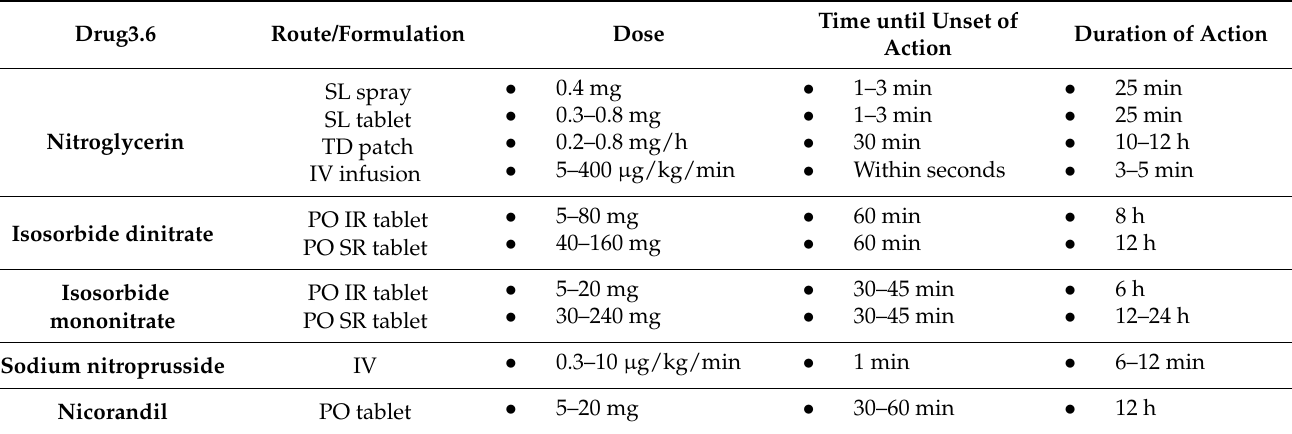
Table 1. Characteristics of the principal nitrovasodilators in clinical practice. Adapted from Divakaran et al.